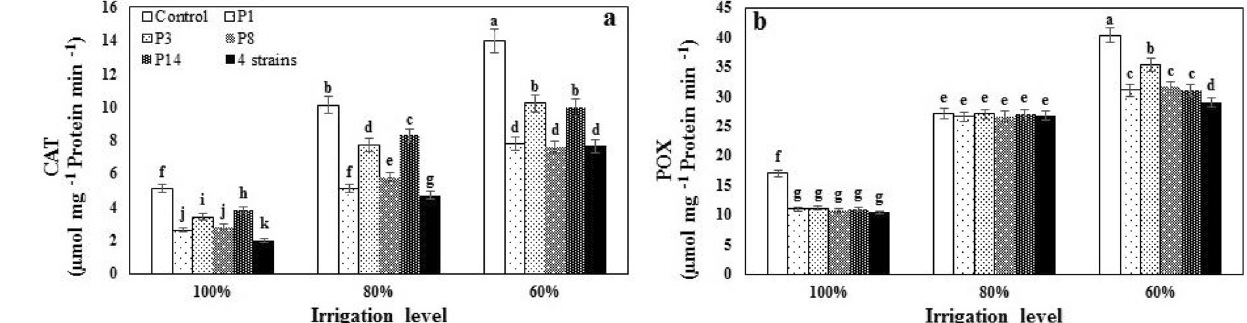
Figure 3. The effect of inoculation with different strains of Pseudomonas fluorescens (P 1 , P 3 , P 8 , P 14 and 4 strains: combination of four strains) under three irrigation levels catalase (CAT) and peroxidase (POX) of sweet a corn leaf. Different letters on mean ± standard error bars showed significant difference (LSD at p ≤